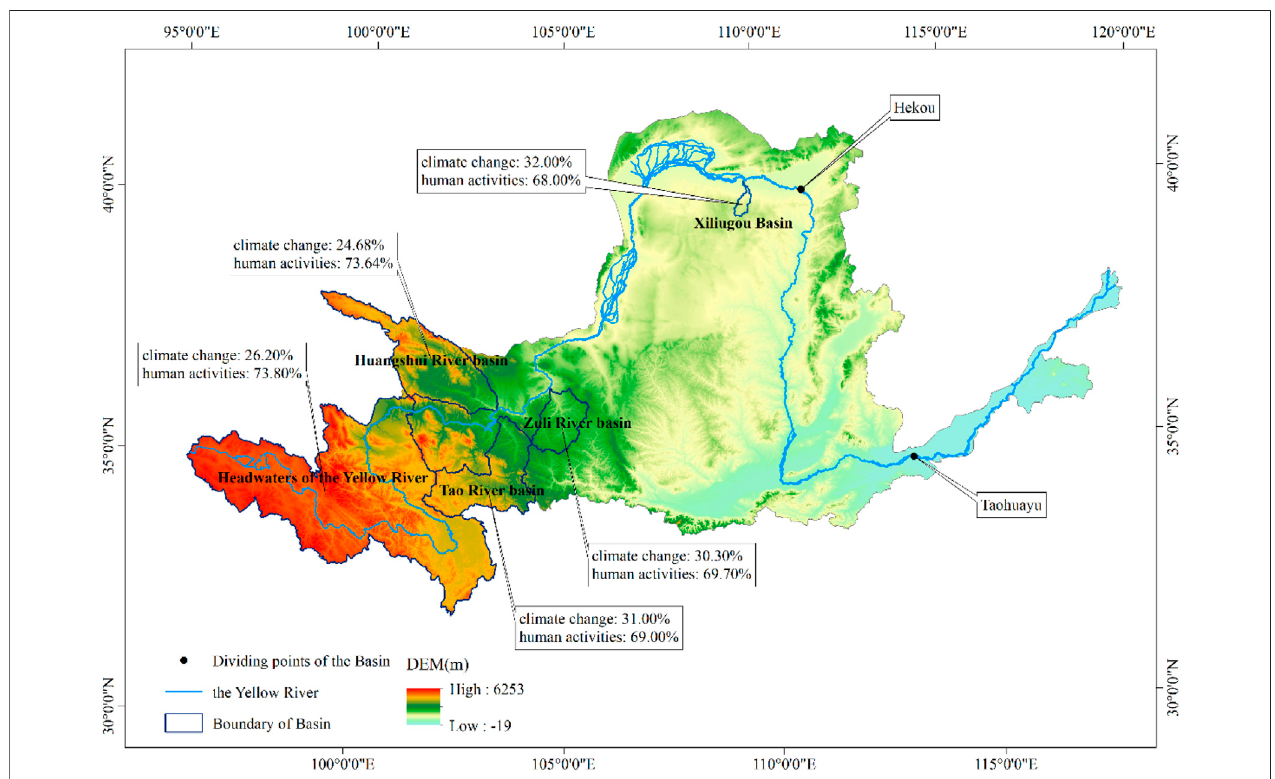
FIGURE 8 | The map focusing on observed impacts of the hydrological response in the upper Yellow River.